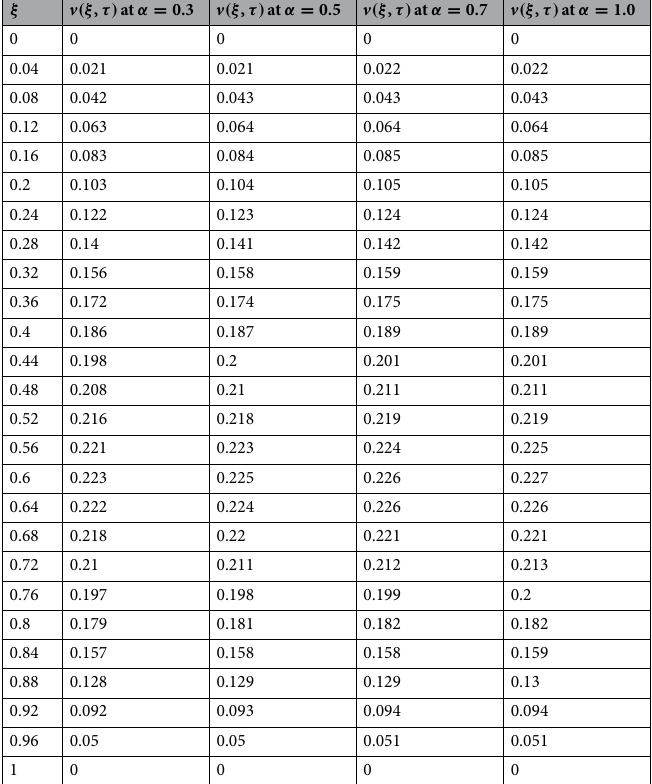
Table 2. Variations in velocity profile against ξ if h (τ) = 0 for different values of α .